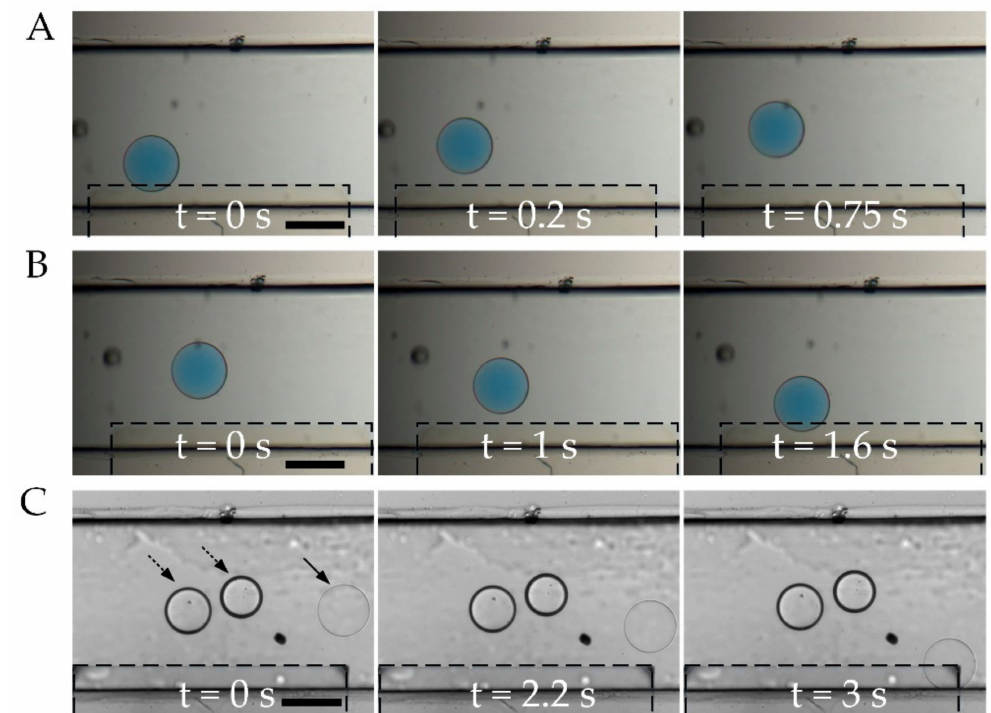
Figure 4. DEP response of droplet with di ff erent shell thicknesses (Movie S1). ( A ) Negative DEP response of droplet (shell thickness 1 µ m) at the field frequency of 50 kHz; ( B ) Positive DEP response of droplet (shell thickness 1 µ m) at the field frequency of 2 MHz; ( C ) Di ff erence of droplet response to the electric field with di ff erent shell thickness. Scale bar, 200 µ